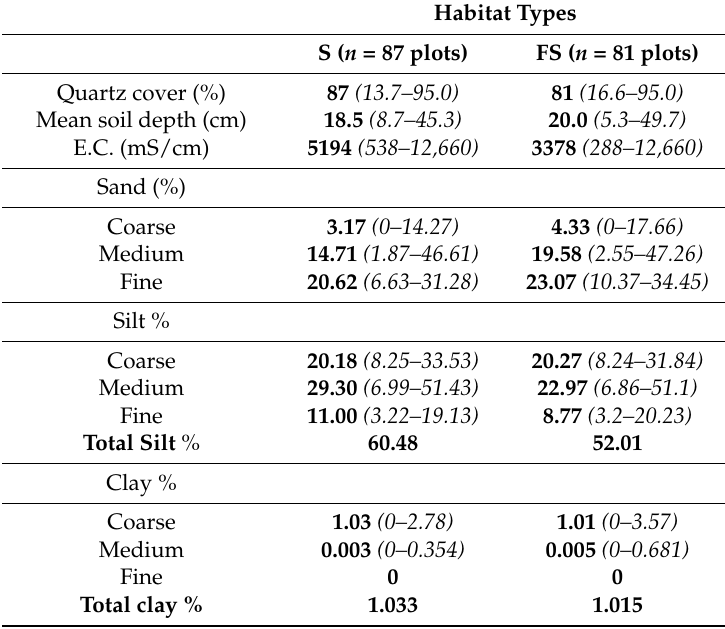
Table 4. Soil characteristics of soils associated with quartz pavements identified as “saline quartz fields.” Data from Schmiedel et al. (2015) and habitat types “S” and “FS” are the designations used in that paper, partly based on associated plant species. Bold-faced values are means; the range of values are italicized in